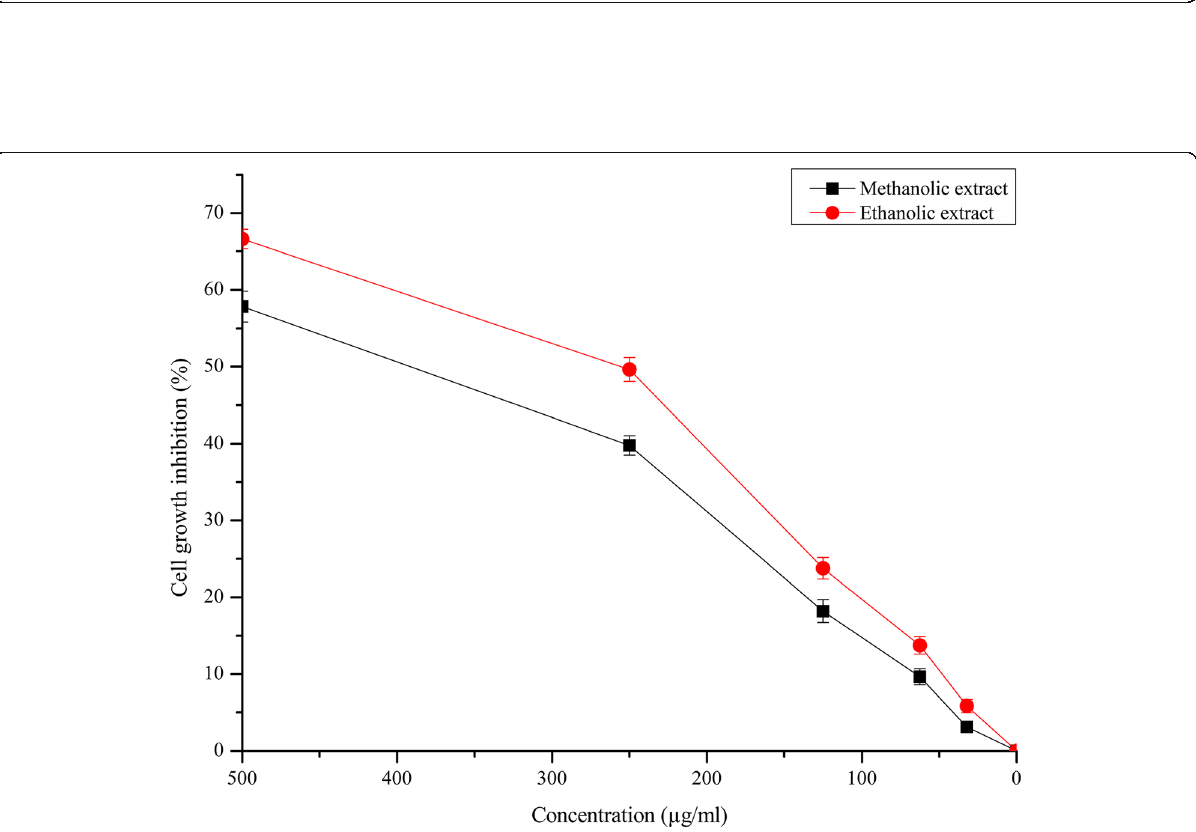
Fig. 5 % Cell growth inhibition of MCF-7 cell lines by methanolic and ethanolic extracts of C. zeylanica leaves. The results were expressed as mean ± standard